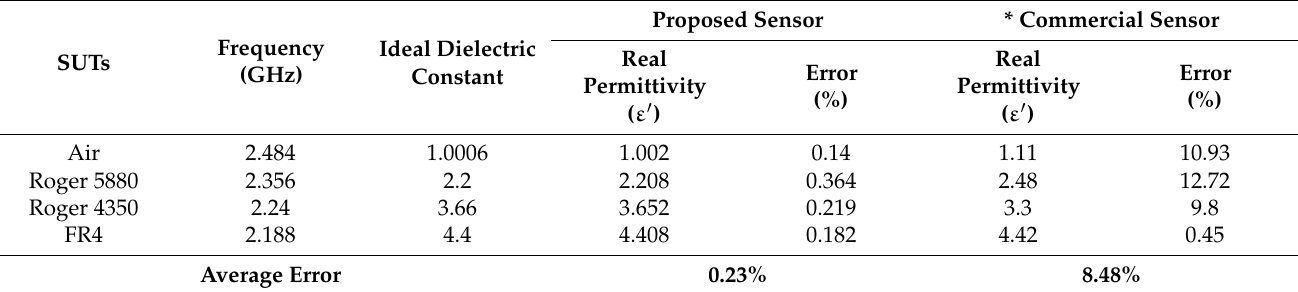
Table 6. Comparison of real permittivity and percentage error detection between the proposed and commercial sensors of several solid SUTs.